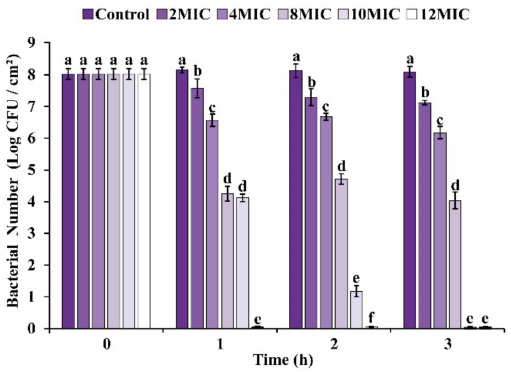
Figure 9. Effects of OEO on the number of viable cells of E. faecalis ATCC 29212 biofilm. Different small letters in each time indicate significant ( p < 0.05) statistical differences among